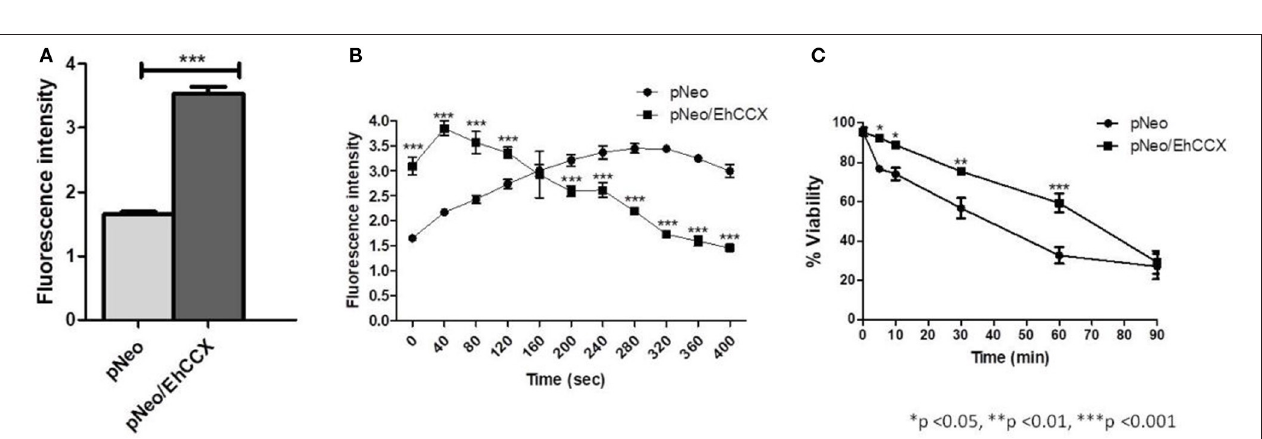
FIGURE 10 | Effect of the EhCCX overexpression on the cytosolic calcium levels and PCD. (A) The cytosolic calcium level of pNeo and pNeo/EhCCX trophozoites in basal conditions was determined by using Fluo4 AM as described in Materials and Methods. (B) pNeo and pNeo/EhCCX trophozoites charged with Fluo4 AM were treated with hydrogen peroxide 1mM and the fluorescence intensity was measured every 40s. (C) The cell viability of trophozoites incubated with hydrogen peroxide 1mM was determined by Trypan blue exclusion at 5, 10, 30, 60, and 90min. Data are expressed as the mean ± standard error of three independent experiments performed by